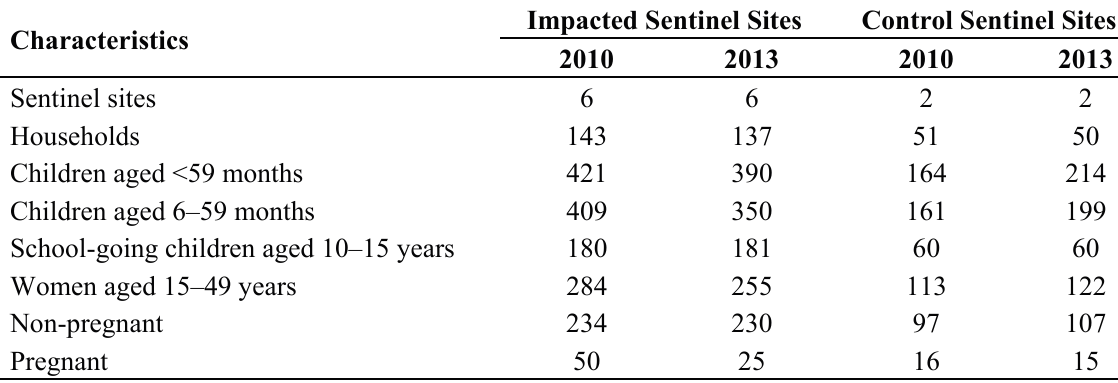
Table 1. Sample sizes at the impacted and the control sentinel sites, in the ABSL project study area, 2010 and